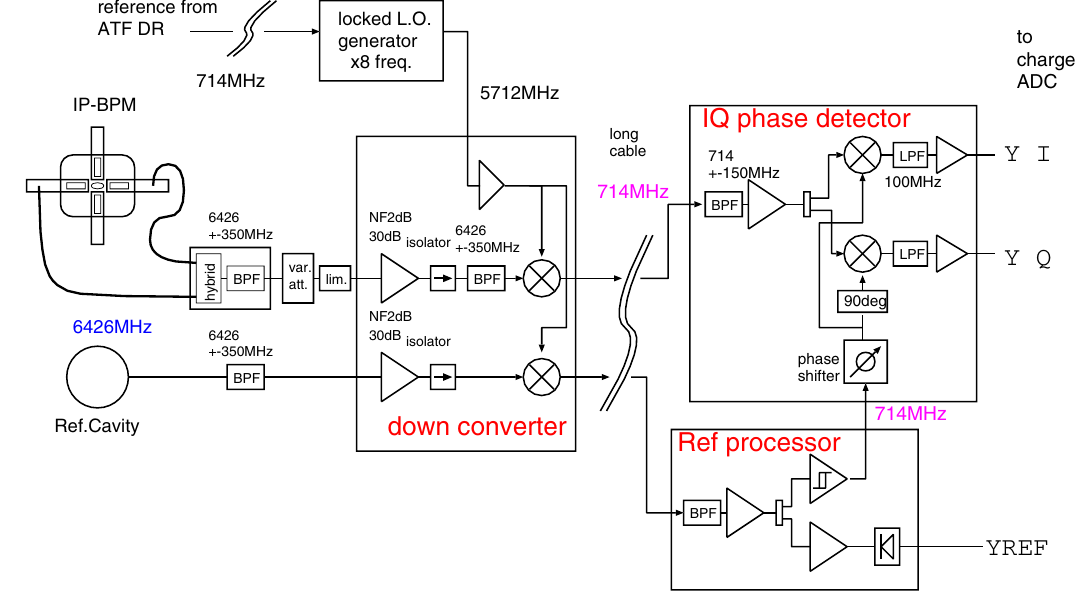
FIG. 10. (Color) Schematic diagram of the electronics. The C-band signal of the BPM cavity and the reference cavity are down- converted to 714 MHz at first. Then, the BPM signal was demodulated into I and Q components using the signal from the reference cavity as the phase reference.